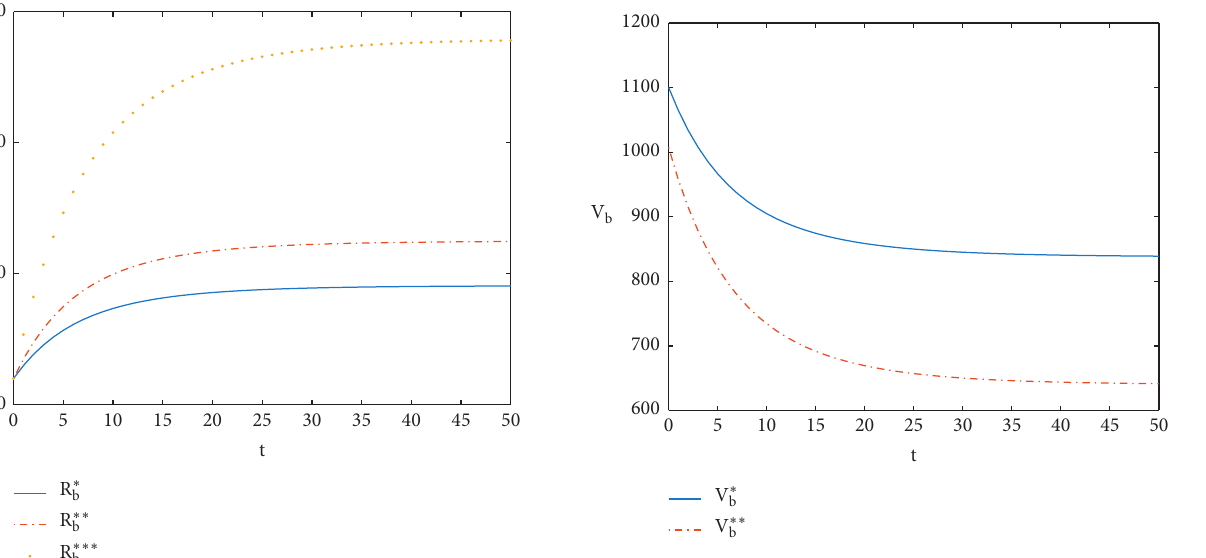
Figure 4: Comparison of environmental pollution losses of Local- gov